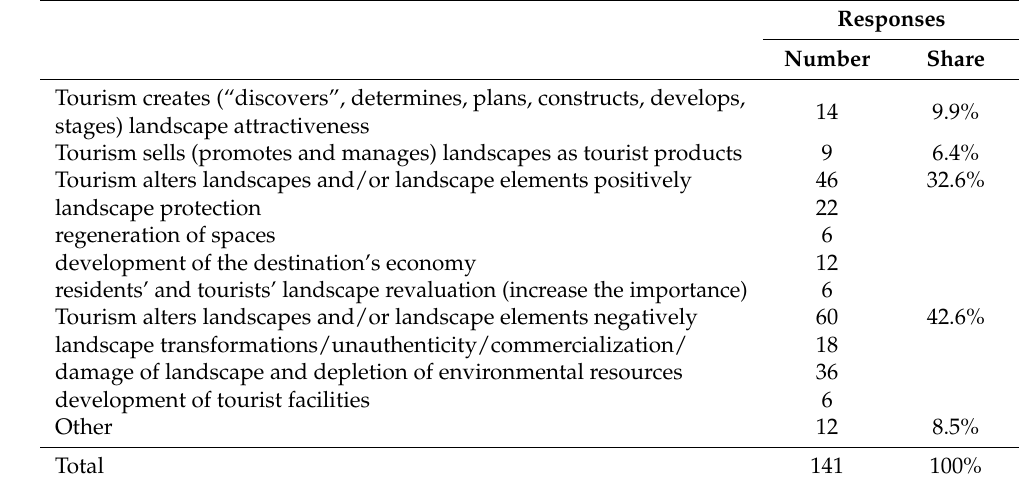
Table 4. Respondents’ views on how tourism affects